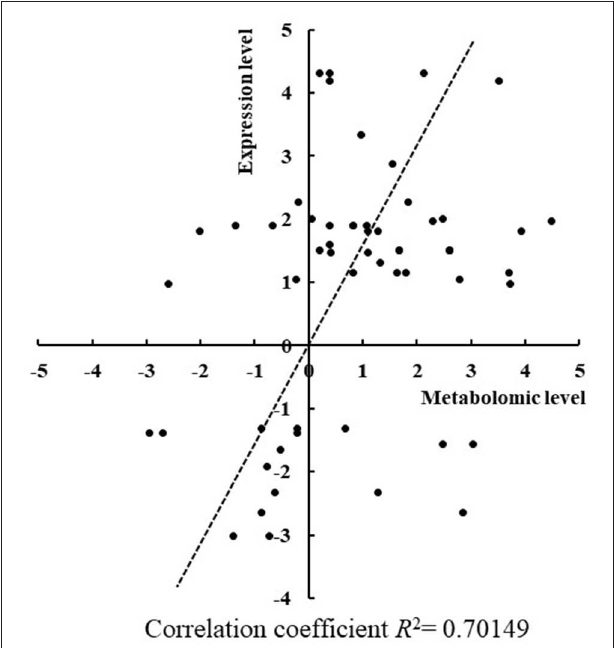
FIGURE 5 | Correlation between changes of gene expression level and metabolomics level in mutants. The changes of gene expression level and metabolomics level showed a good correlation since R 2 =